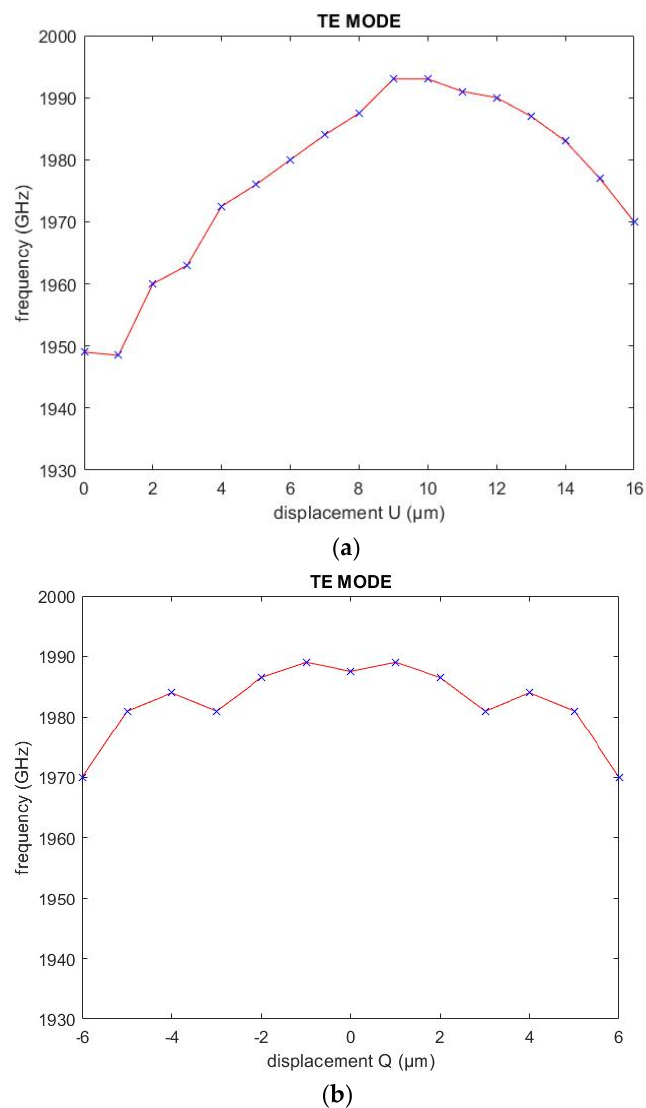
Figure 8. Resonance frequency values while changing the I-shaped position in TE mode: ( a ) change in resonance frequency value when moving the center I-column metal bar up in 2 µm increments to a maximum excursion of 16 µm; ( b ) change in resonance frequency value when moving the center column right and left in 2 µm up to a maximum excursion of 6 µm for a rightward shift and − 6 µm for a leftward shift. Shifting in this direction is done for a value of U equal to 8 µm, i.e., at the center position of the moving I-shaped column.